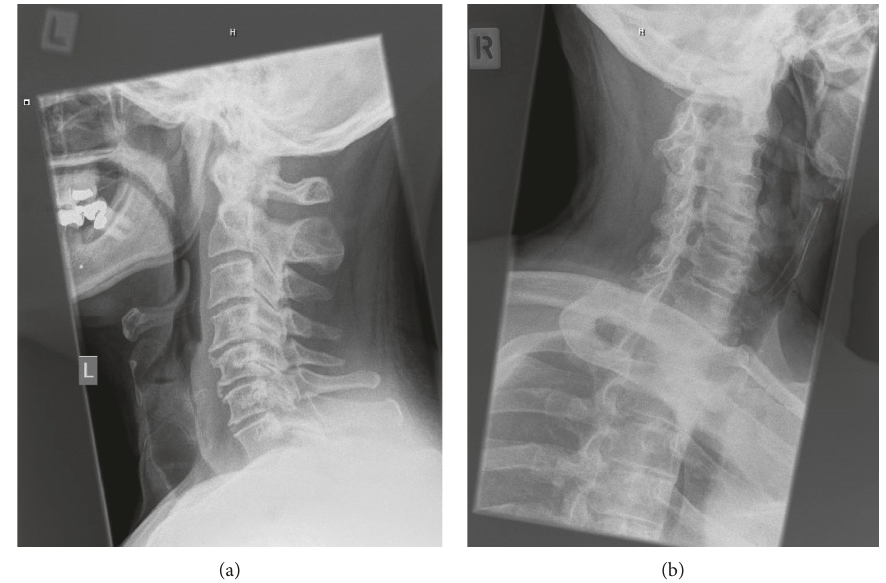
Figure 2: Preoperative AP and oblique cervical spine radiographs showing degenerative